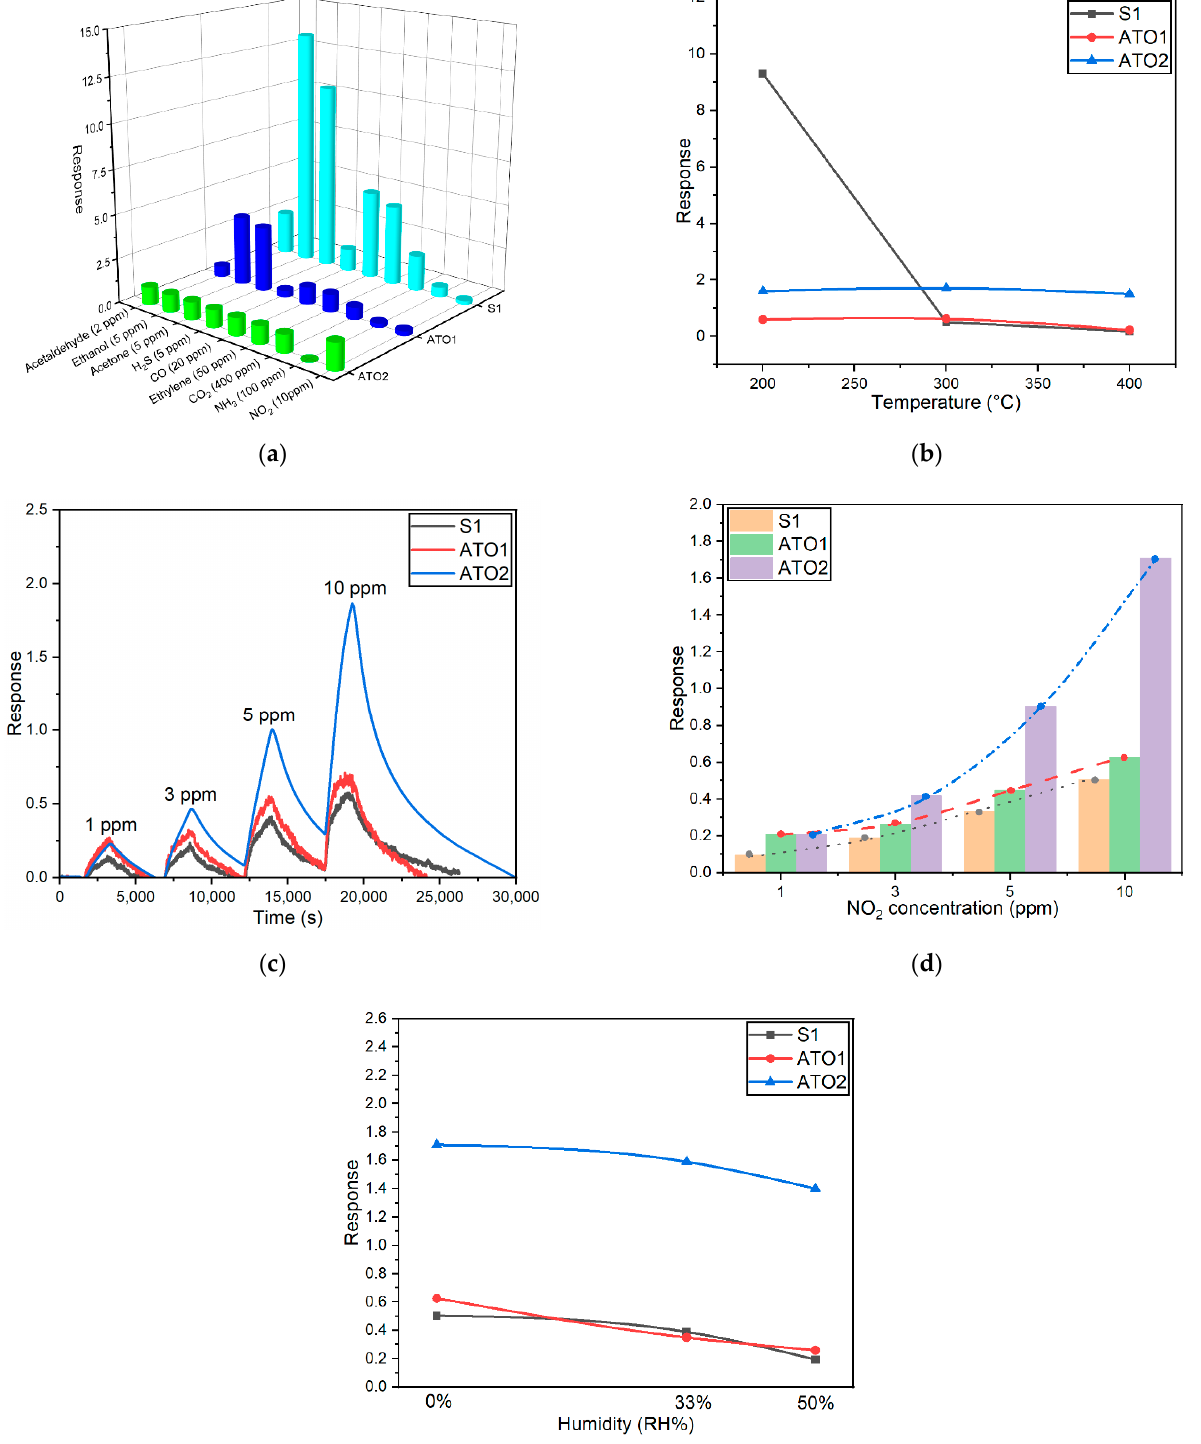
Figure 6. Electrical characterizations of the fabricated sensors: ( a ) response to different gases at 400 ◦ C in dry air; ( b ) response to 10 ppm of NO 2 at different operating temperatures in dry air; ( c ) dynamical response of the three sensors towards 1, 3, 5, and 10 ppm NO 2 at 300 ◦ C; ( d ) variation of the response vs. NO 2 concentrations for the three sensors in dry air at 300 ◦ C; ( e ) response to different humidity at 300 ◦ C under 10 ppm NO 2